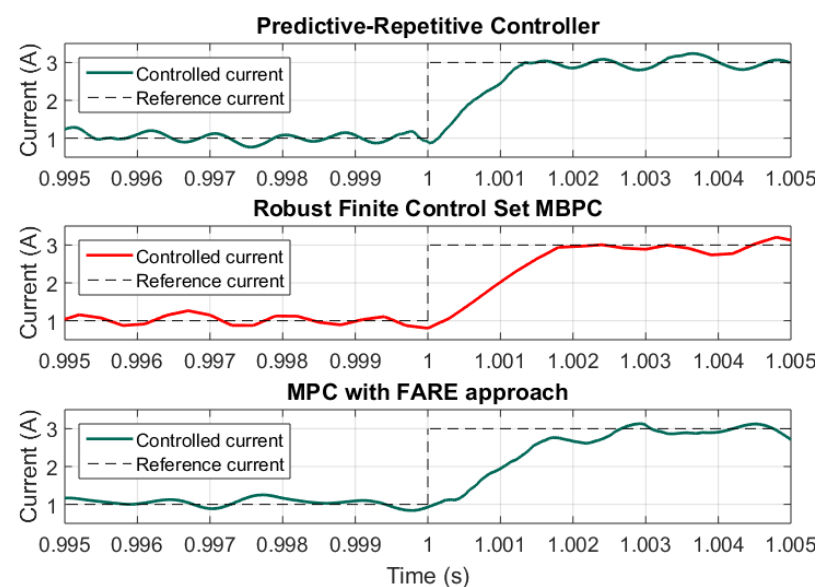
Figure 12. Comparison of the step response time of the proposal and other strategies [45,48].